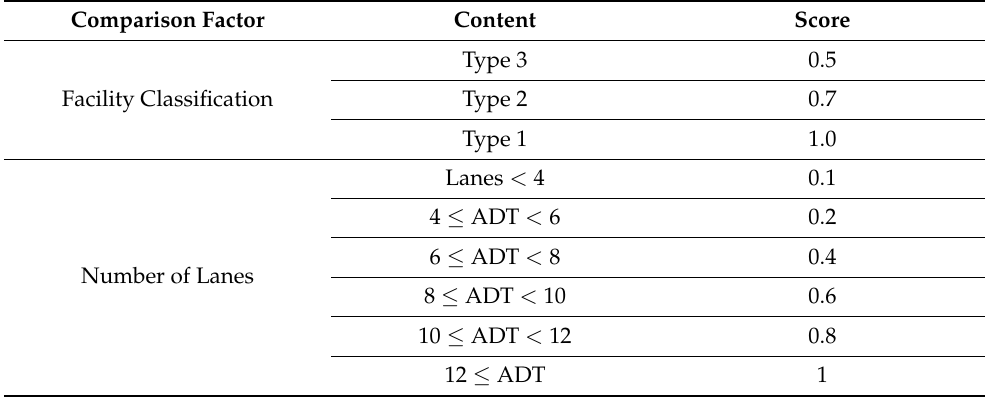
Table 5. Scores by comparison